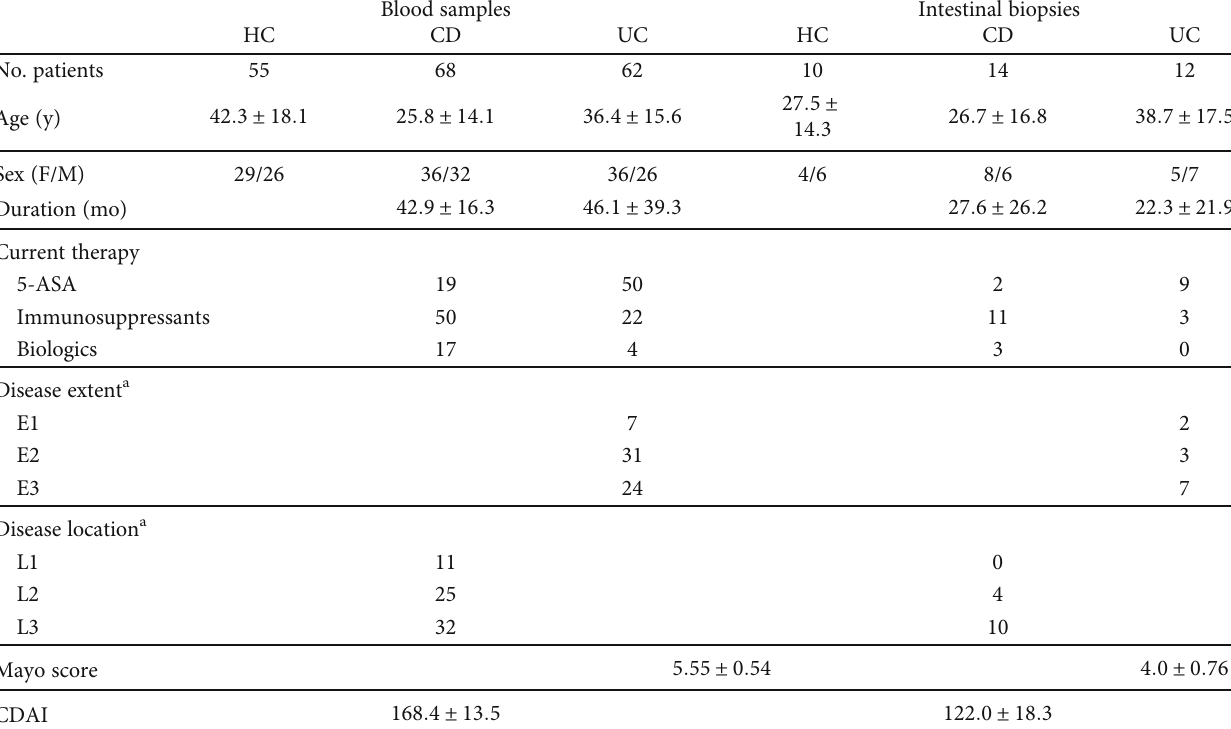
Table 1: Demographics and clinical characteristics of the study